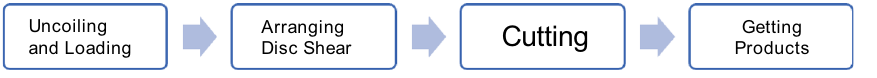
Figure 3. Steel cutting process.